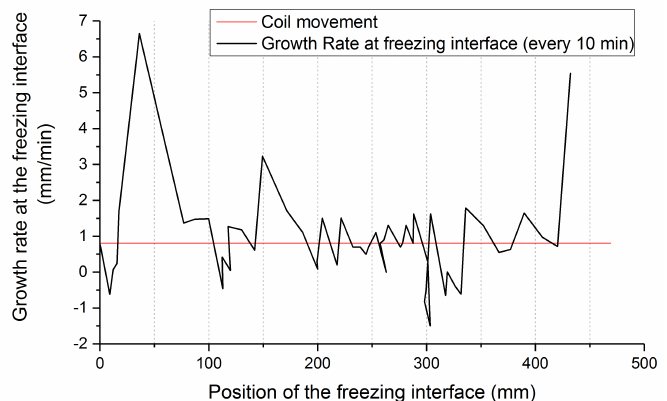
Figure 14. Variation of the growth rate at the freezing interface along the bar.